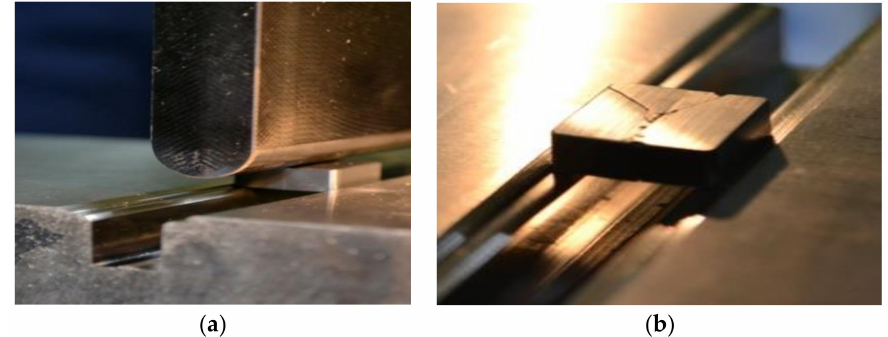
Figure 4. The rigging for evaluating the bending strength of the ceramic inserts: ( a ) view of the working zone; ( b ) the insert after breaking and removing the